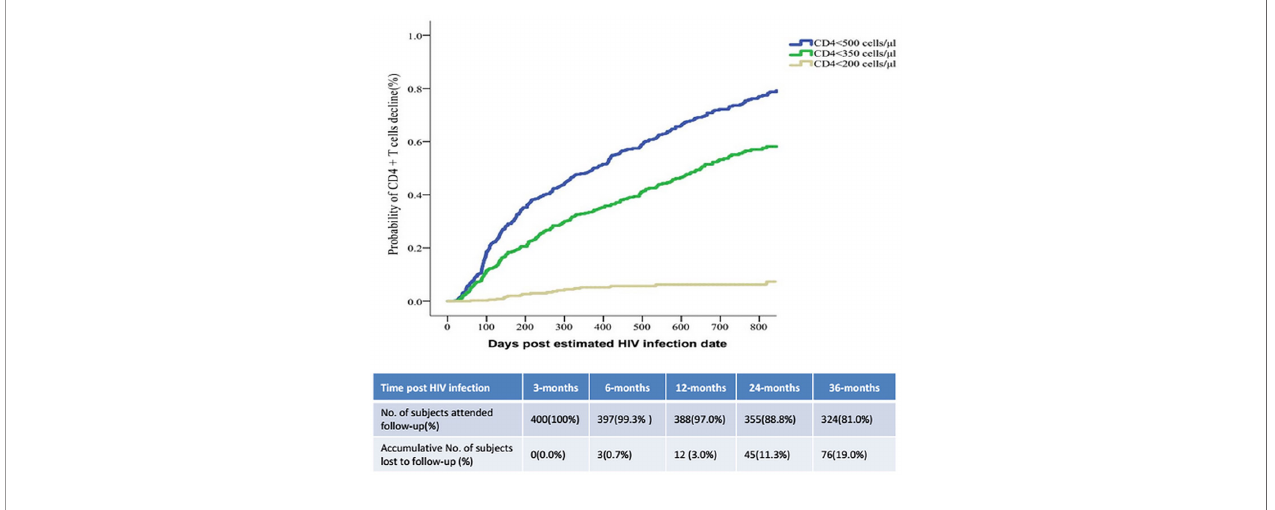
FIGURE 3 | The speed of immunological progression events of CD4+T cell counts decreasing post HIV infection.